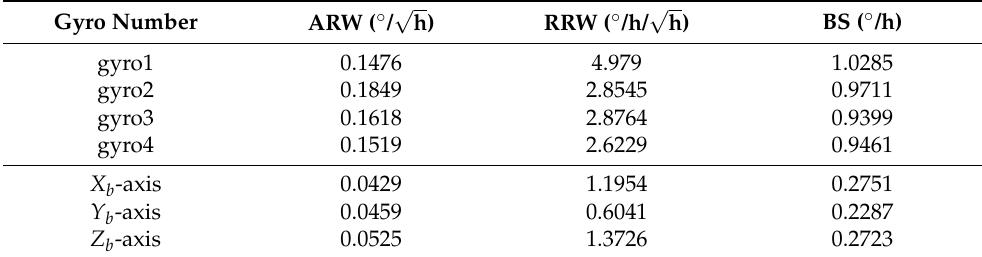
( b ) Figure 21. The static estimated results of 4-MIMU. ( a ) The outputs of gyros. ( b ) The estimated rate of the MIMU on the X b , Y b and Z b axes.